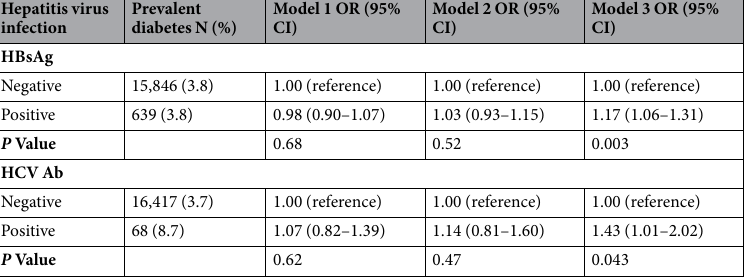
(Supplement Table 2) in the fully-adjusted model. In a study population restricted to HBsAg ( − ) participants ( n = 423,001), the adjusted odds ratio of prevalent diabetes between HCV Ab ( + ) and HCV Ab ( − ) participants was 1.51 (95% CI 1.06–2.13, P = 0.02).